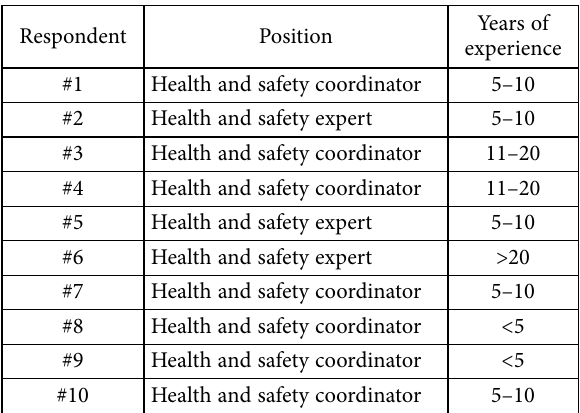
Table 2. Profiles of the